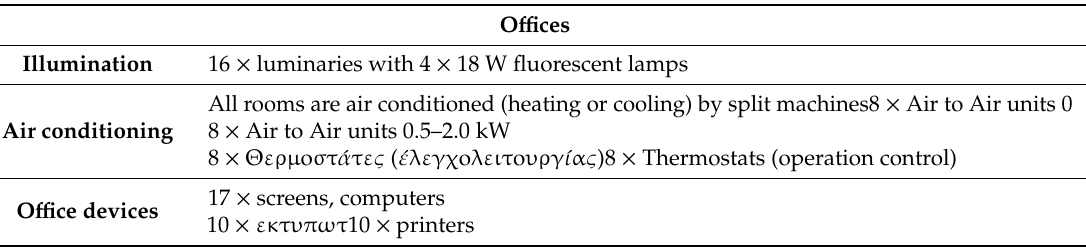
Table 1. Installation load